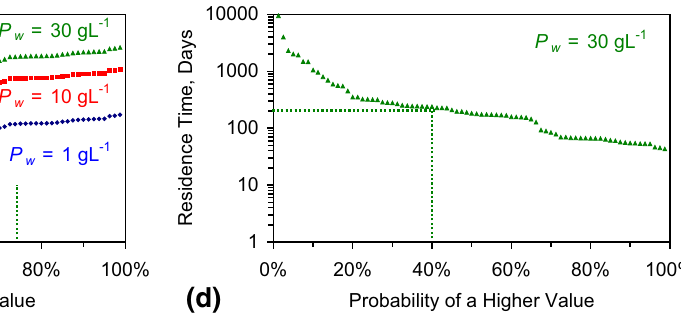
y = -0.0749x - 6.3654 R 2 = 0.3364